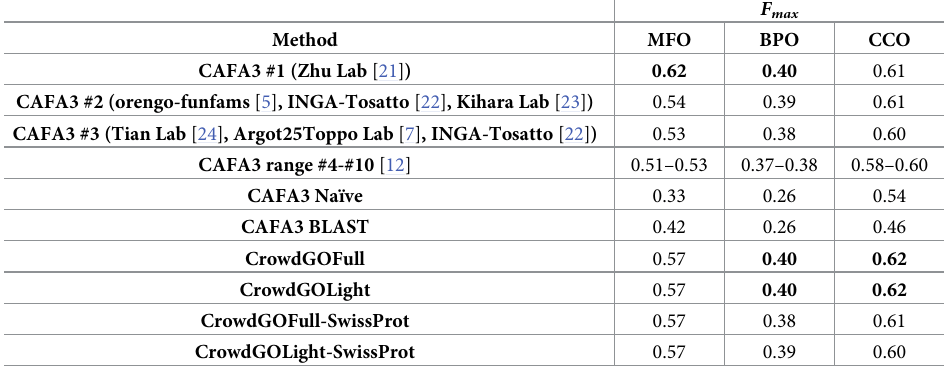
Table 3. F max scores for CrowdGO and the baseline and top three performers from CAFA3. Molecular Function (MFO), Biological Process (BPO), and Cellular Component (CCO) ontologies; Highest F max scores are in bold